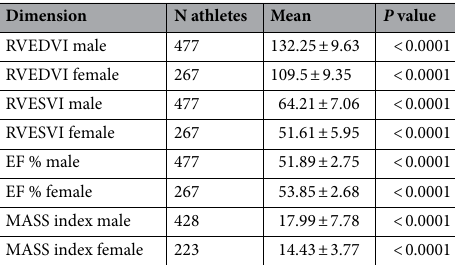
Table 7. T test between CMR means (only studies with both male and female data shown separately) and reference means.